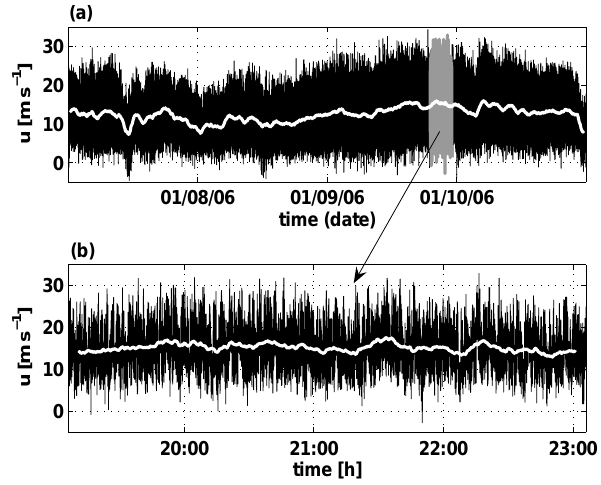
Fig. 3. (a) A 4 day raw 4Hz data time series (from 7 to 11 January 2006) of the streamwise wind component measured in Senj, with the 1h mean superimposed. (b) The strongest 4h interval (grey area in Fig. 3a) chosen for the detailed analysis with the 10min mean